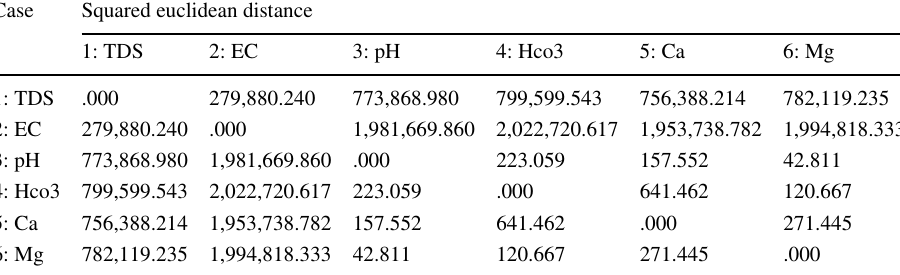
This is a dissimilarity